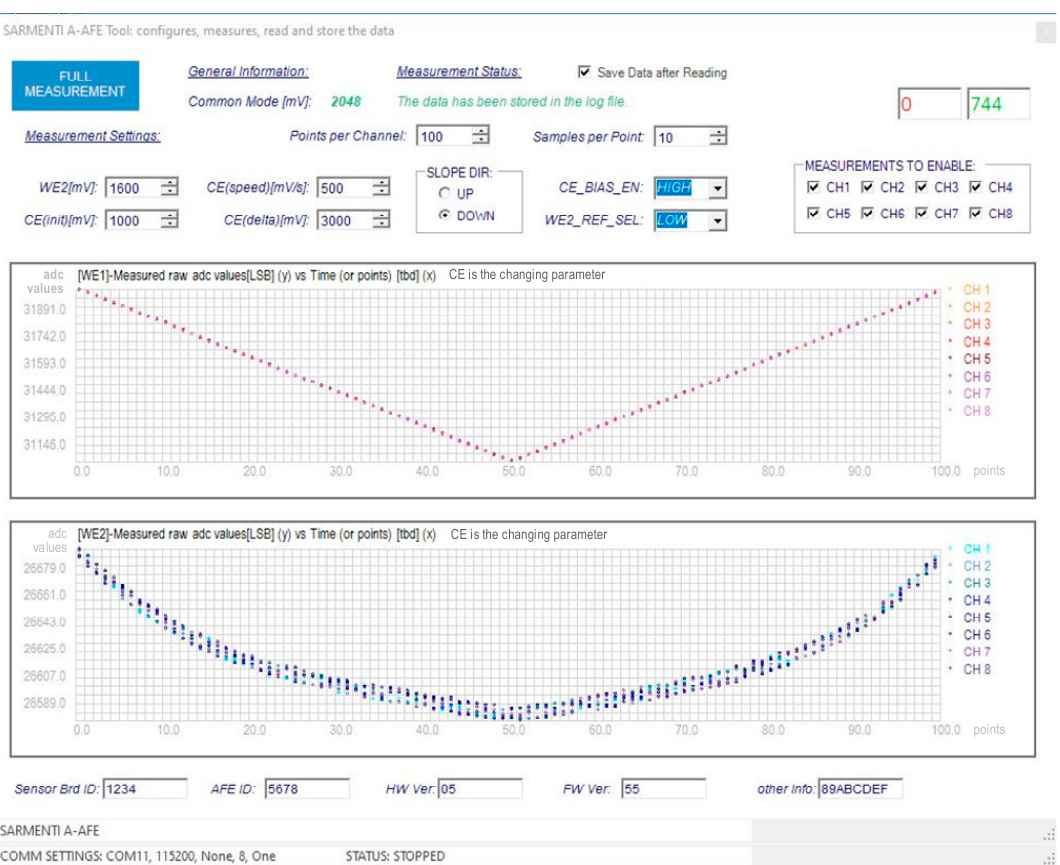
Figure 23. Measurement values in the SDL PCTool.